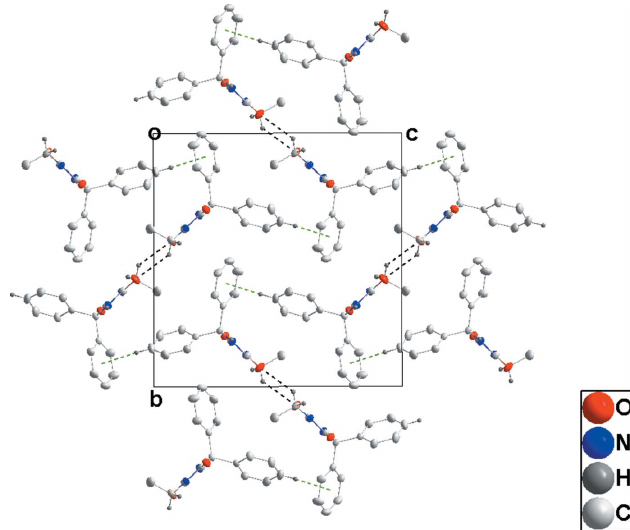
Figure 3 Packing viewed along the a -axis direction showing the association of chains through C—H (cid:3)(cid:3)(cid:3) (cid:2) (ring) interactions (green dashed lines).